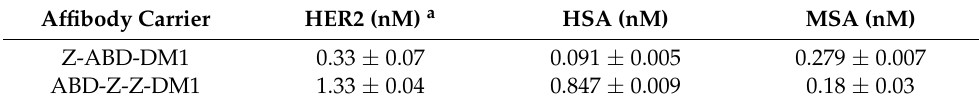
Table 4. The equilibrium dissociation constants between the constructs and HER2 or SAs.